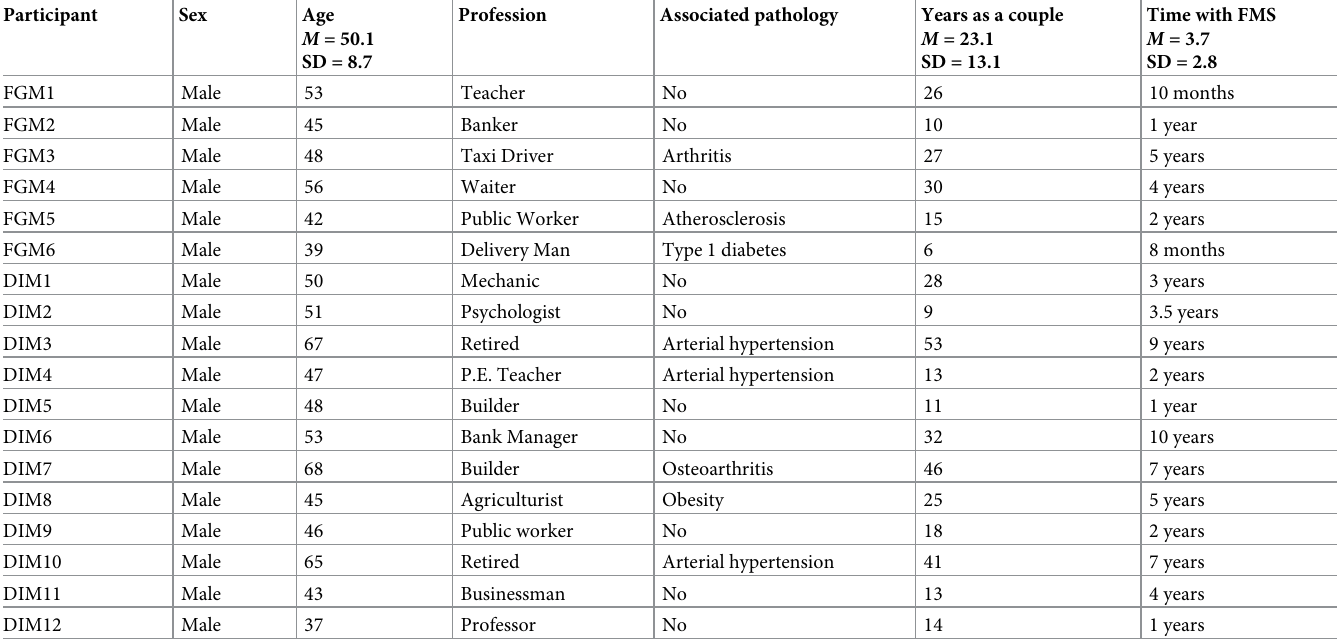
Table 1. Socio-demographic data of the participants (N =